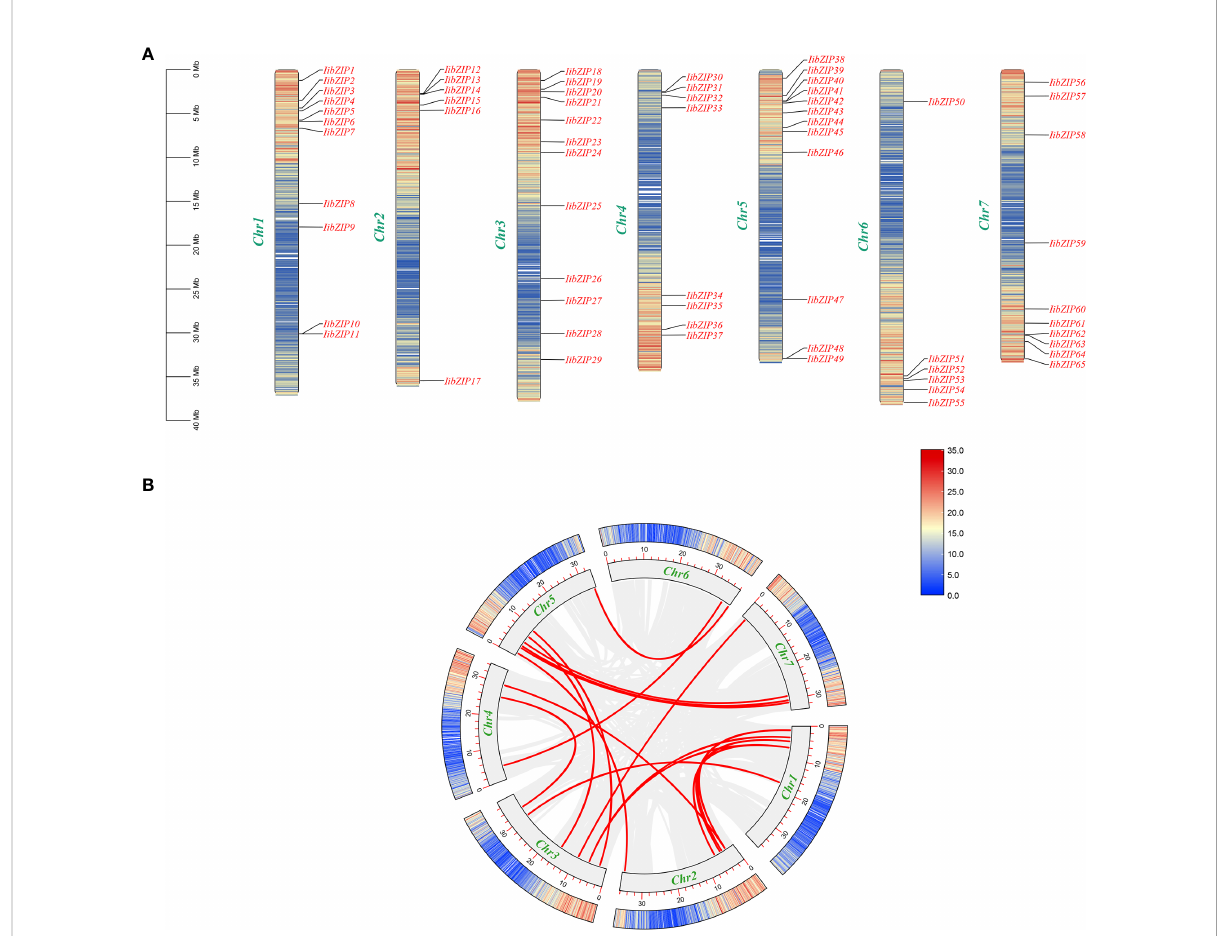
FIGURE 1 Chromosomal distribution of IibZIP genes and predicted gene replication events in the ( I ) indigotica genome. (A) Location of IibZIP genes on I indigotica chromosomes. (B) Gene duplication events in the genome. A red line represents collinearity of the IibZIP gene, and a gray line represents all collinear pairs in the ( I ) indigotica